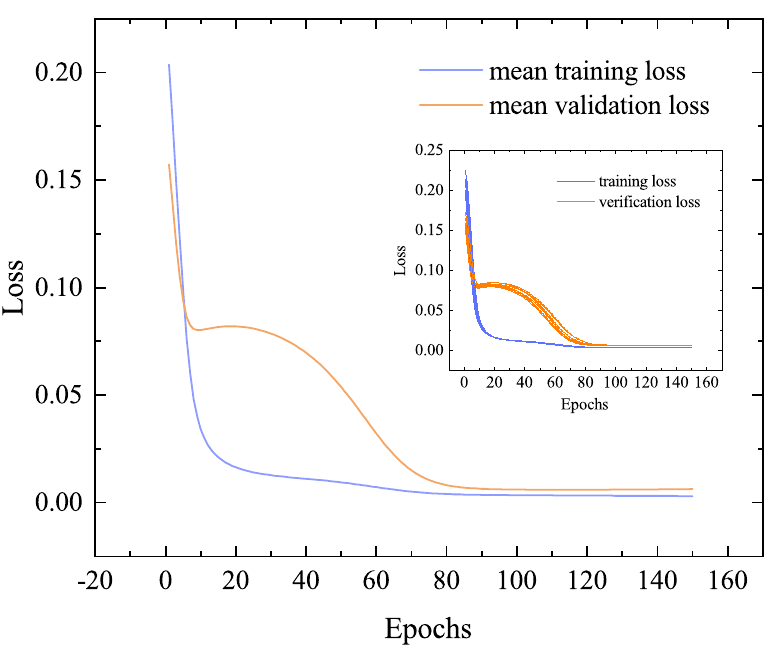
Figure 10. The training and verification loss. As shown in Figure 11, the values of performance indicators in 10 repeated experi- ments are in comparison with the results in Section 4.1, where the solid line represents prediction error of each trial, the dashed line represents average prediction error, and the box chart shows the distributions of prediction error.